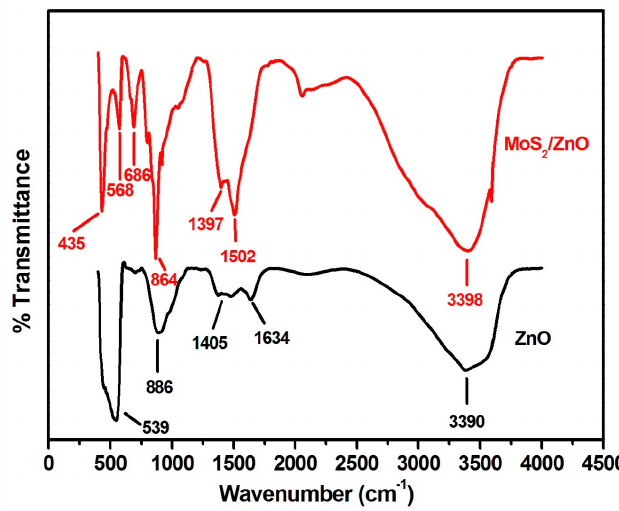
Figure 5. Typical FT-IR spectra of prepared ZnO nanoparticles and MoS 2 -ZnO heterostructure